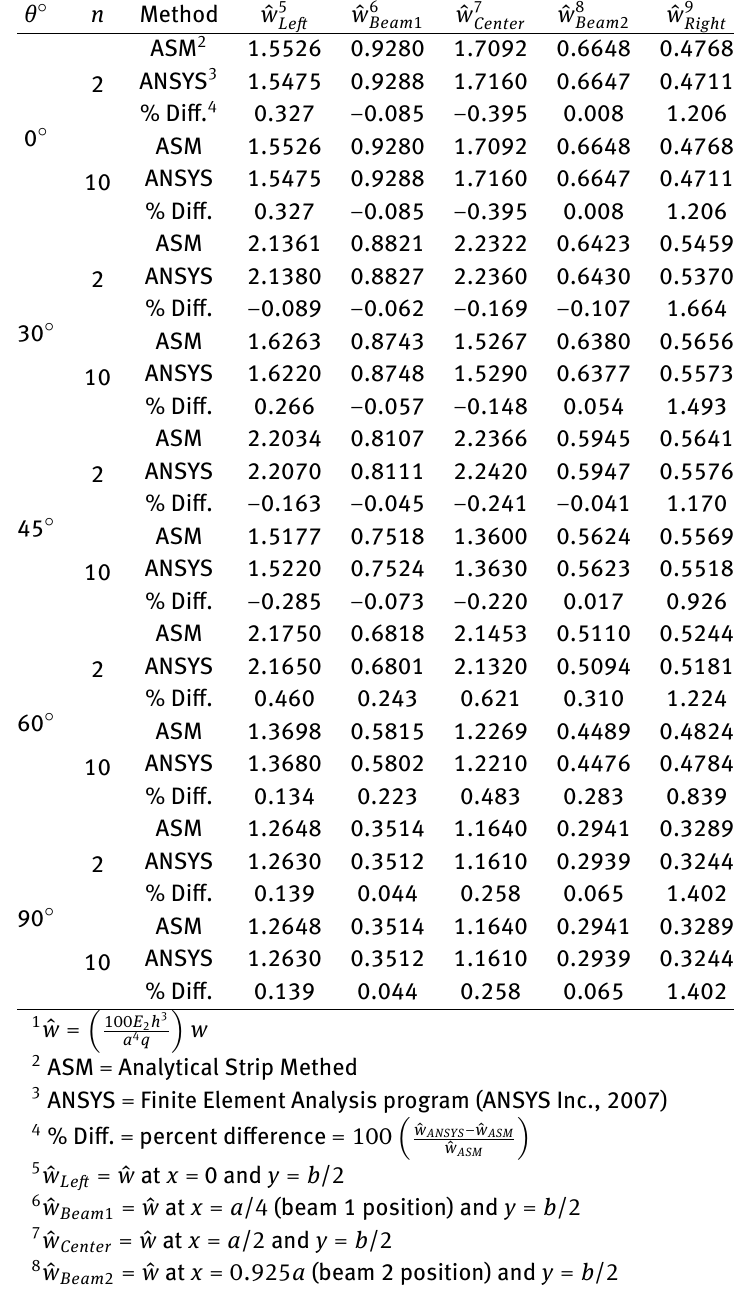
Table 7: Effect of ply angle, θ and number of layers, n , on the deflection ^ w 1 of a uniformly loaded rectangular antisymmetric angle-ply plate ( a / b = 2, θ ∘ / − θ ∘ / θ ∘ / . . . / − θ ∘ ) with two internal beam supports (Fig. 4) ( b / h = 1000, E 1 = 132.38 GPa, E 2 = 10.76 GPa, G 12